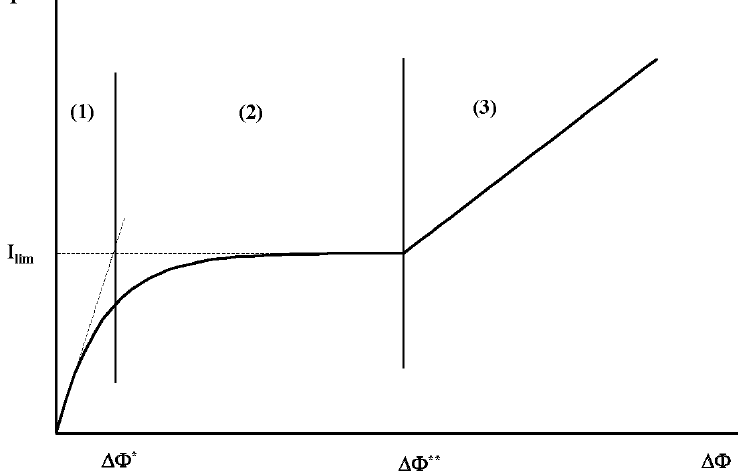
Figure 1. Schematic drawing of the current density ( I ) vs. potential drop ( ∆Φ ) over a membrane system. The regions (1), (2) and (3) localize the Ohmic regime, the limiting current regime and the overlimiting current regime respectively.